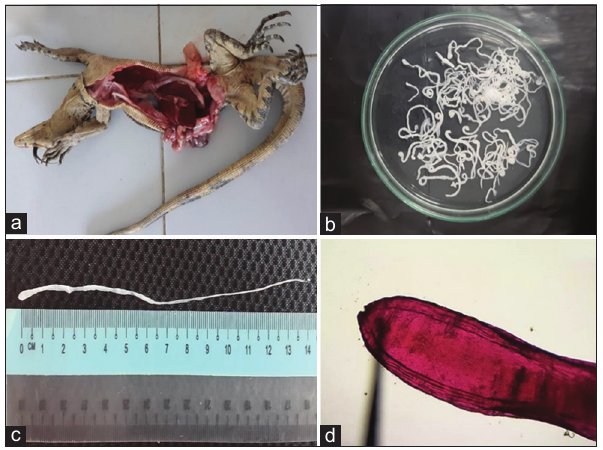
Figure-1: (a) Varanus salvator sample during necropsy, (b) plerocercoids collected from Varanus salvator , (c) a plerocercoid measured approximately 14 cm length, (d) photomicrograph of anterior end of plerocercoid stage of Spirometra parasite using carmine staining method and 100×